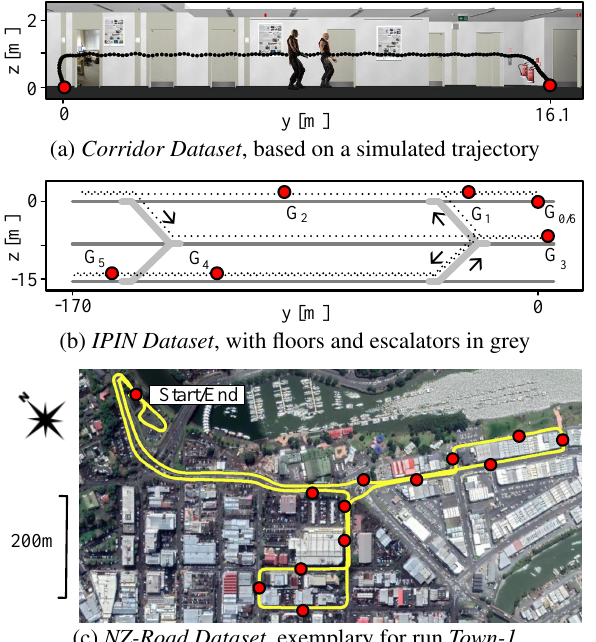
(c) NZ-Road Dataset , exemplary for run Town-1 Figure 4. Illustration of exemplary trajectories (black dotted, yellow solid lines) and real world GCPs (red